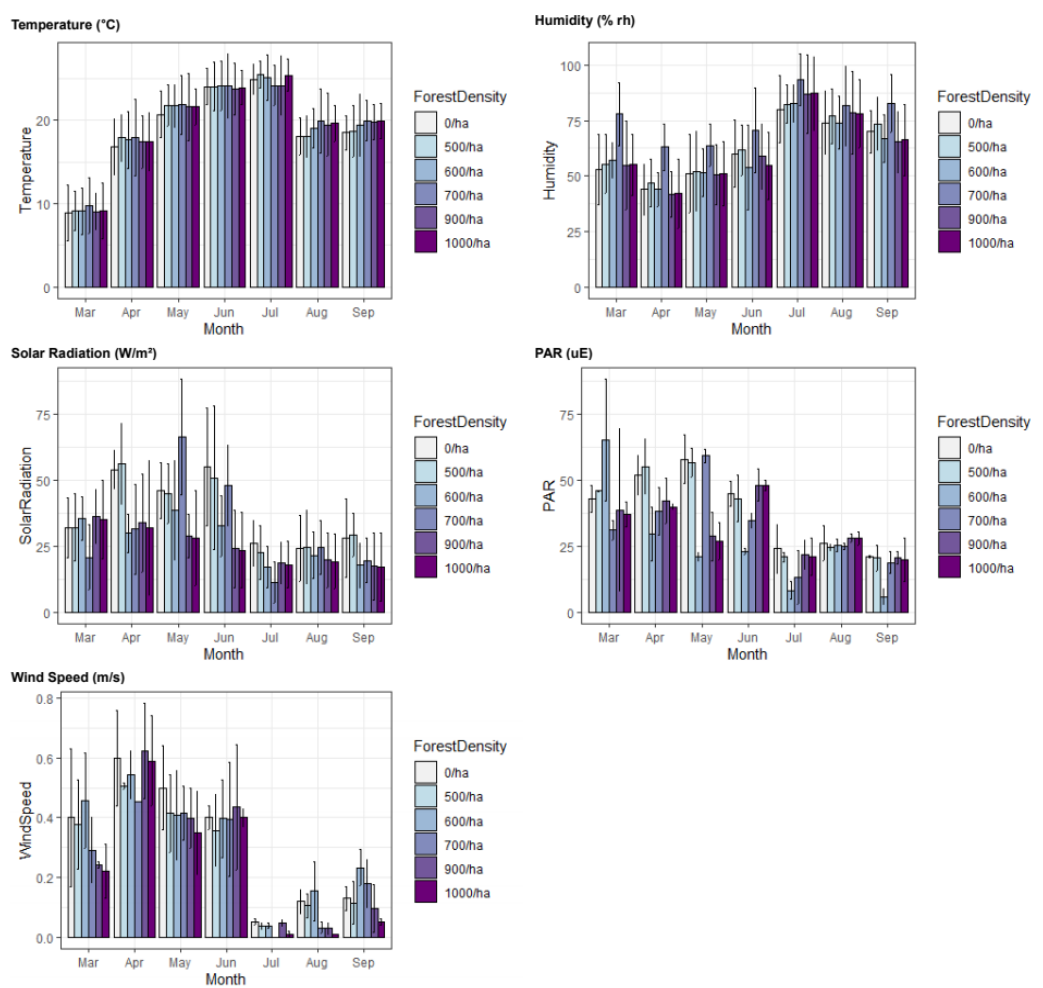
Figure 6. Bar charts of monthly microclimate environment fluxes according to forest density. Units of each microclimate factors: temperature (°C), humidity (% rh), solar radiation (W/m²), PAR (uE), and wind speed (m/s).